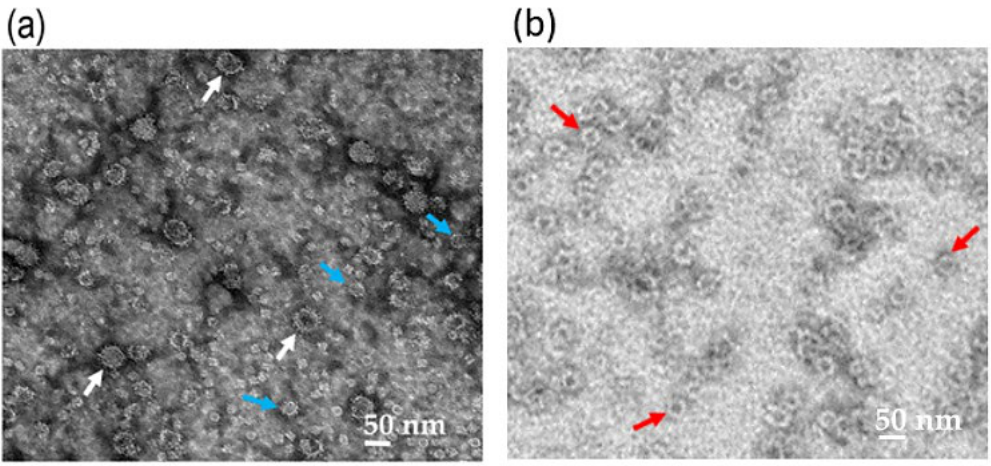
Figure 2. Transmission electron micrograph of the Nc-aD protein. Transmission electron micrographs of the Sf 9-produced Nc-aD protein ( a ), and E. coli -produced Nc-aD protein ( b ). Transmission electron microscopic analysis showed that the Sf 9-produced Nc-aD protein assembled into virus-like particles (VLPs) ranging from ~21 nm (blue arrows) to ~55 nm (white arrows) in diameter, while the E. coli - produced Nc-aD protein assembled into VLPs of ~30 nm (red arrows) in diameter. The white bars indicate 50